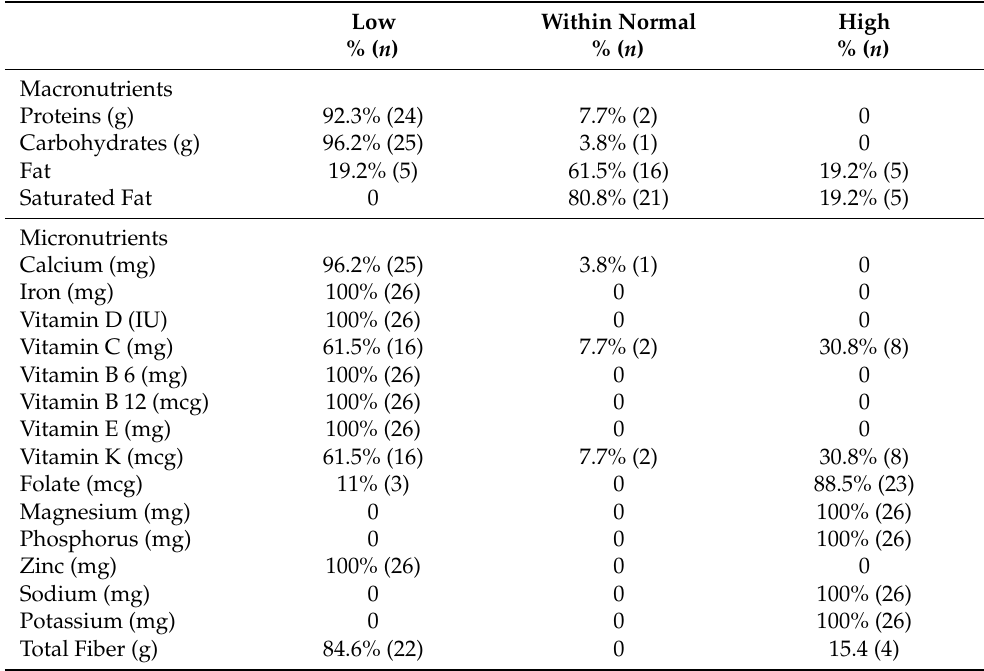
Table 7. Nutritional intake for 1 week among dancers ( n =